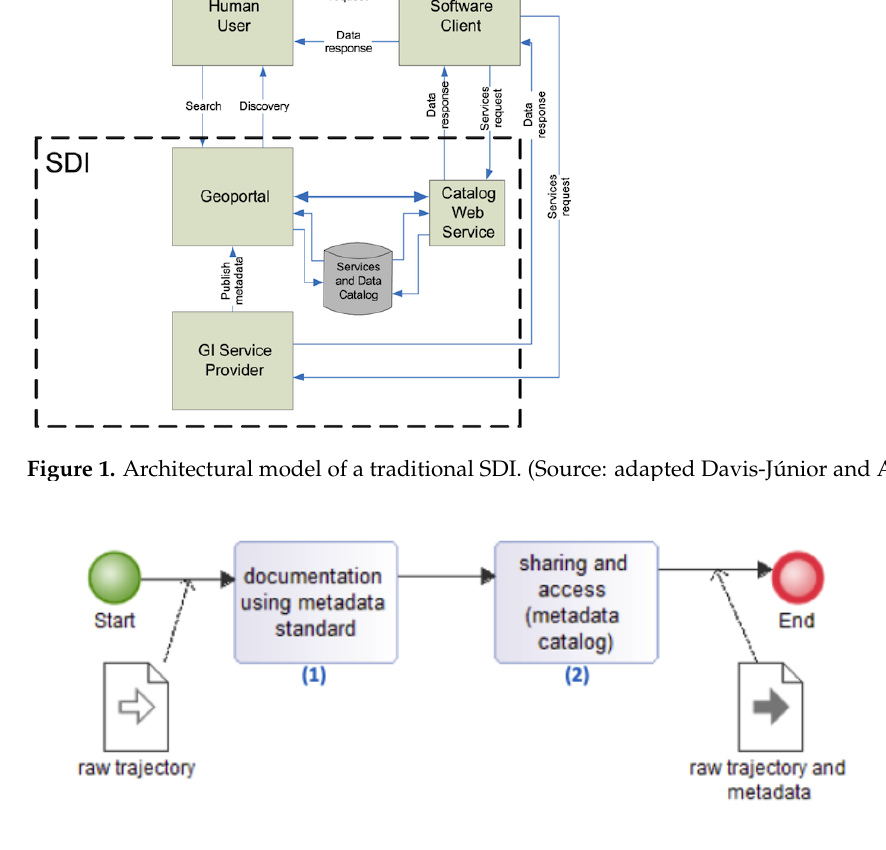
Figure 2. Documentation of trajectories in traditional